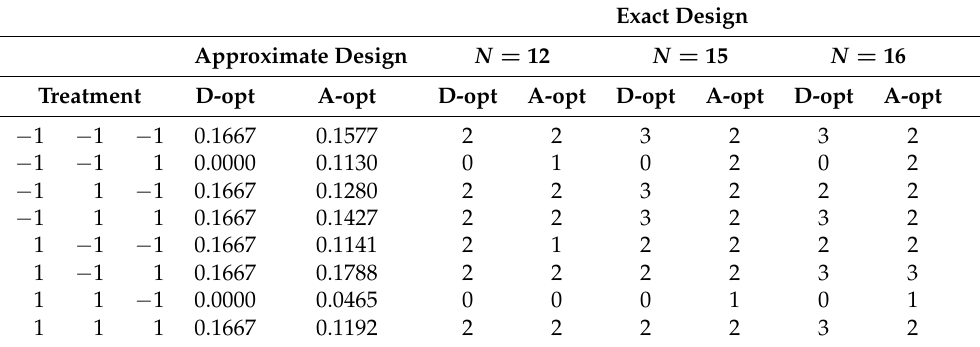
Table 6. D- and A-optimal designs for Model 5 where k = 8 and N = { 12,15,16 }